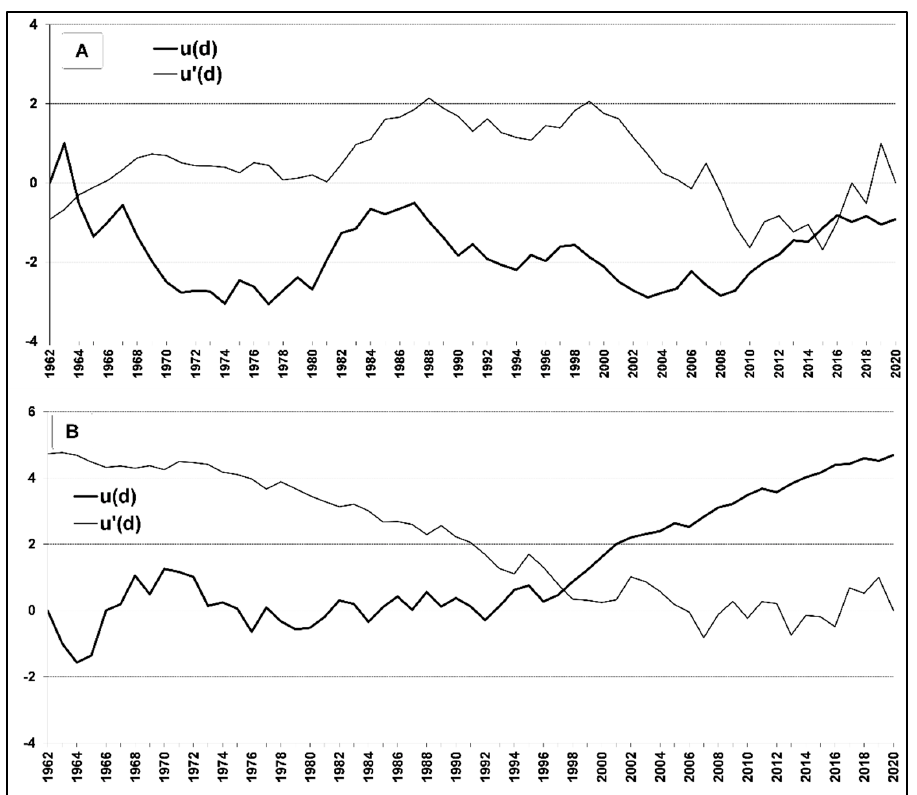
Figure 4. Graphical representation of sequential Mann-Kendall test for annual precipitation ( A ) and for the mean annual temperatures ( B ) in Pertouli, with forward trend u(d) (solid line) and backward trend u’(d) (dashed line) at the 0.05 confidence level.